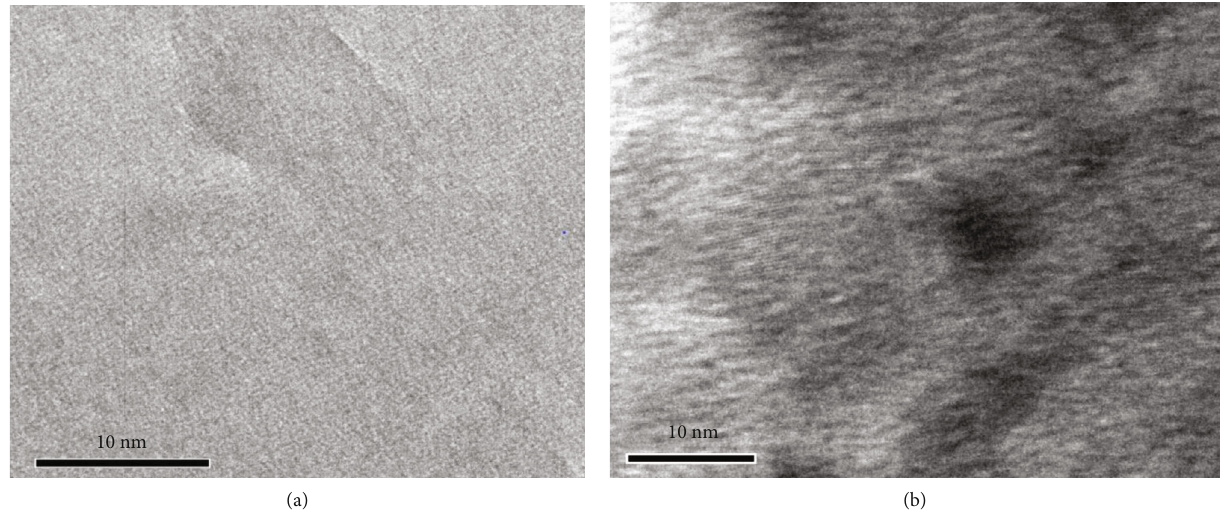
Figure 3: TEM micrographs of (a) uncoated and (b) MnO-coated hollow PMMA